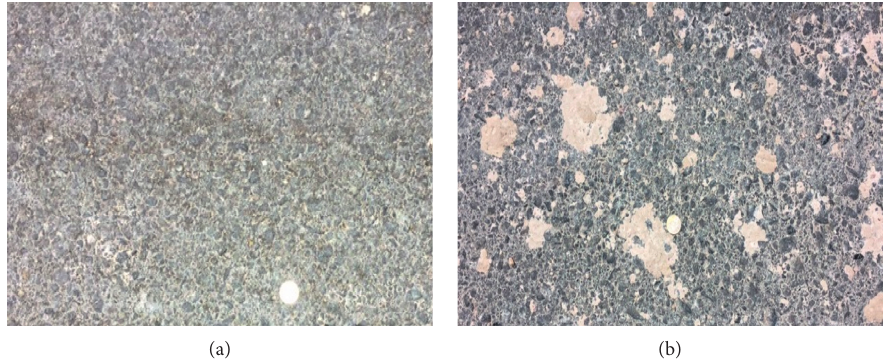
Figure 12: A photographic view of Rawad Al Rashed road. (a) Typical section. (b) Section with